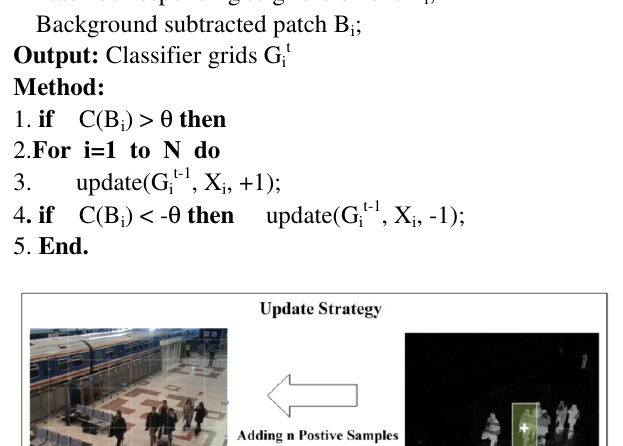
Algorithm 4: Classifier Grids Update